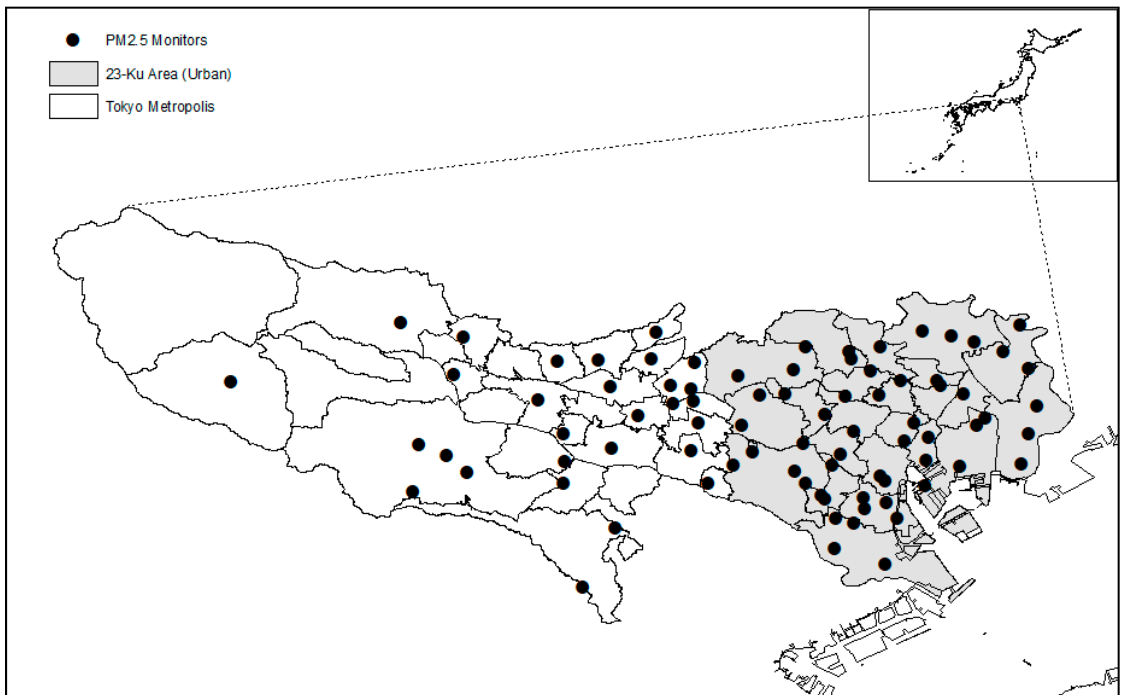
Figure 1. Map of administrative districts of Tokyo Metropolis and the distribution of ground monitoring stations of PM 2.5 , 2000–2019.